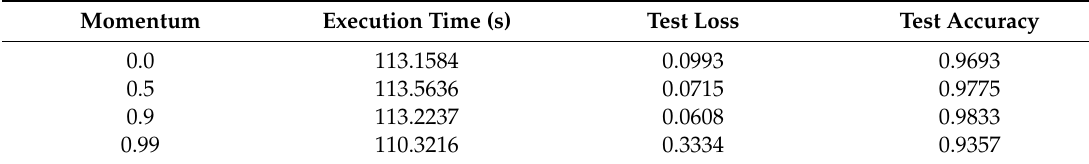
Table 17. E ff ect of momentum on multilayer